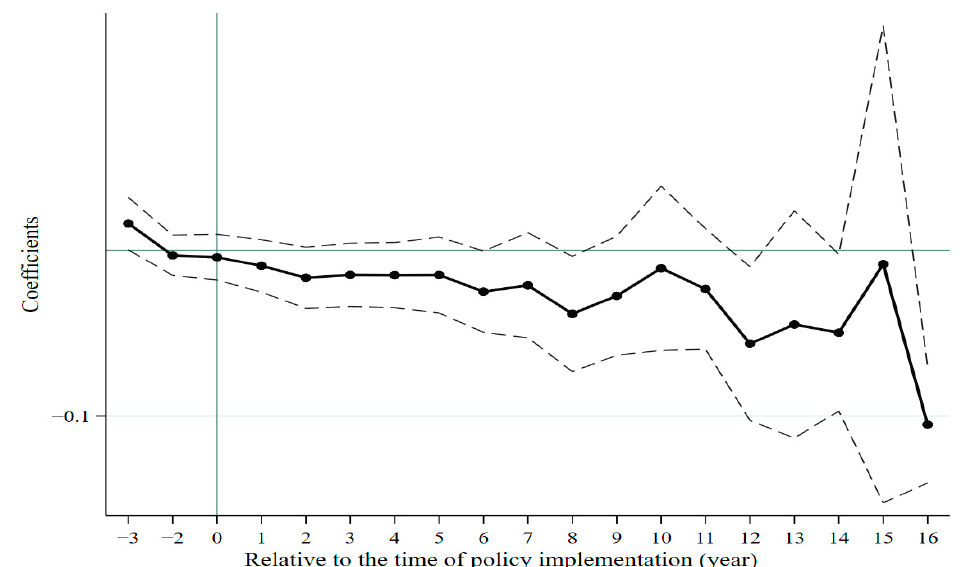
Figure 1. Parallel trend test. Note: the successive broken lines re fl ect the marginal e ff ects created by national forest cities, and the do tt ed lines above and below are con fi dence intervals below the 95% level.